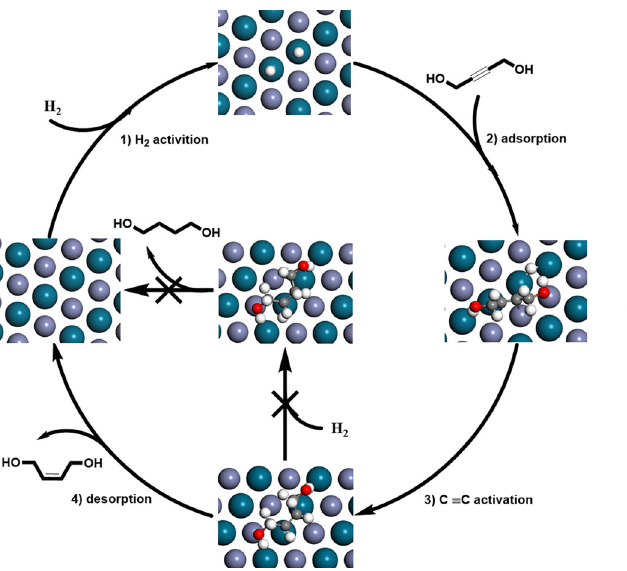
Fig. 6 Reaction mechanism. Reaction mechanism of the selective hydrogenation of BYD over intermetallic